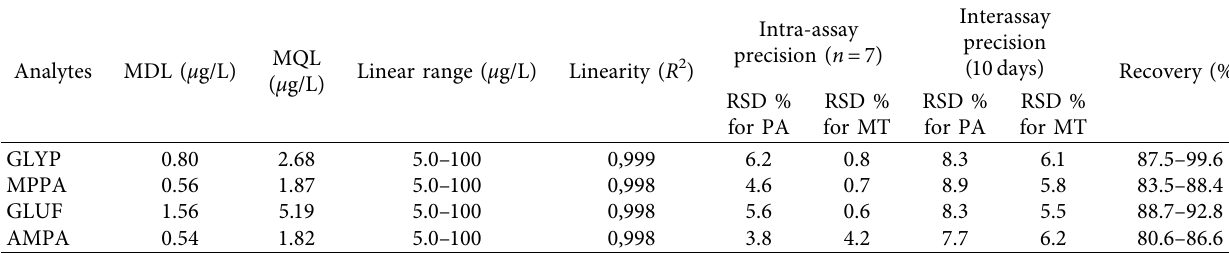
Table 1: Salient performance data for the determinations of GLYP, GLUF, AMPA, and MPPA with the purpose-made CE-C4D system. Conditions: channel 1: GLYP, GLUF, and MPPA analysis: BGE solution:1.0M His/Ace (pH � 3.0); voltage: 20kV; capillary: uncoated fused